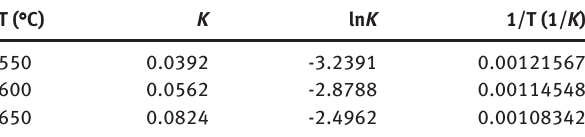
Table 8: Relationship between ln K and 1/T.